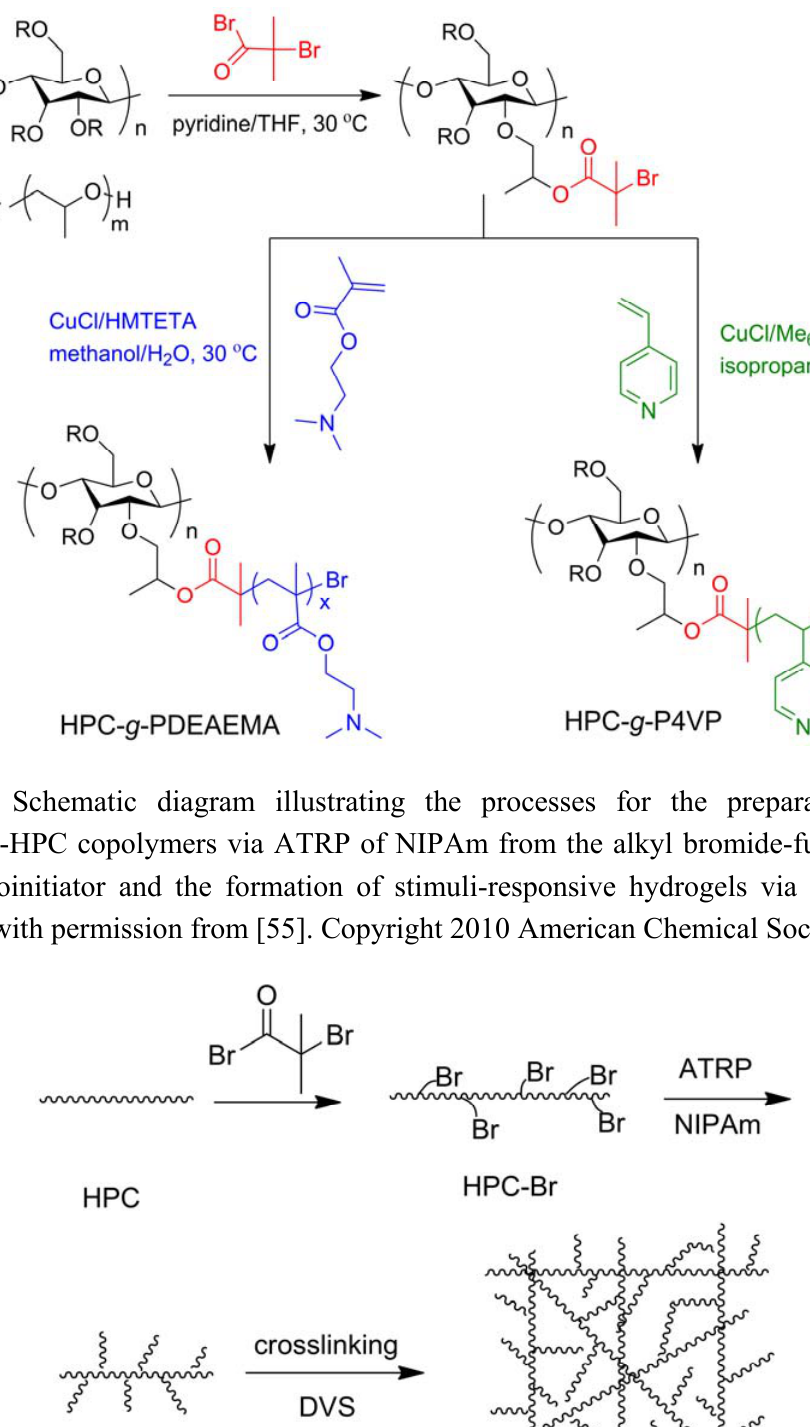
Figure 7. Synthesis route of the poly( N , N -dimethyl aminoethyl methacrylate) (PDMAEMA) and poly(4-vinyl pyridine) (P4VP) grafted HPC via atom transfer radical polymerization (ATRP) [53,54].